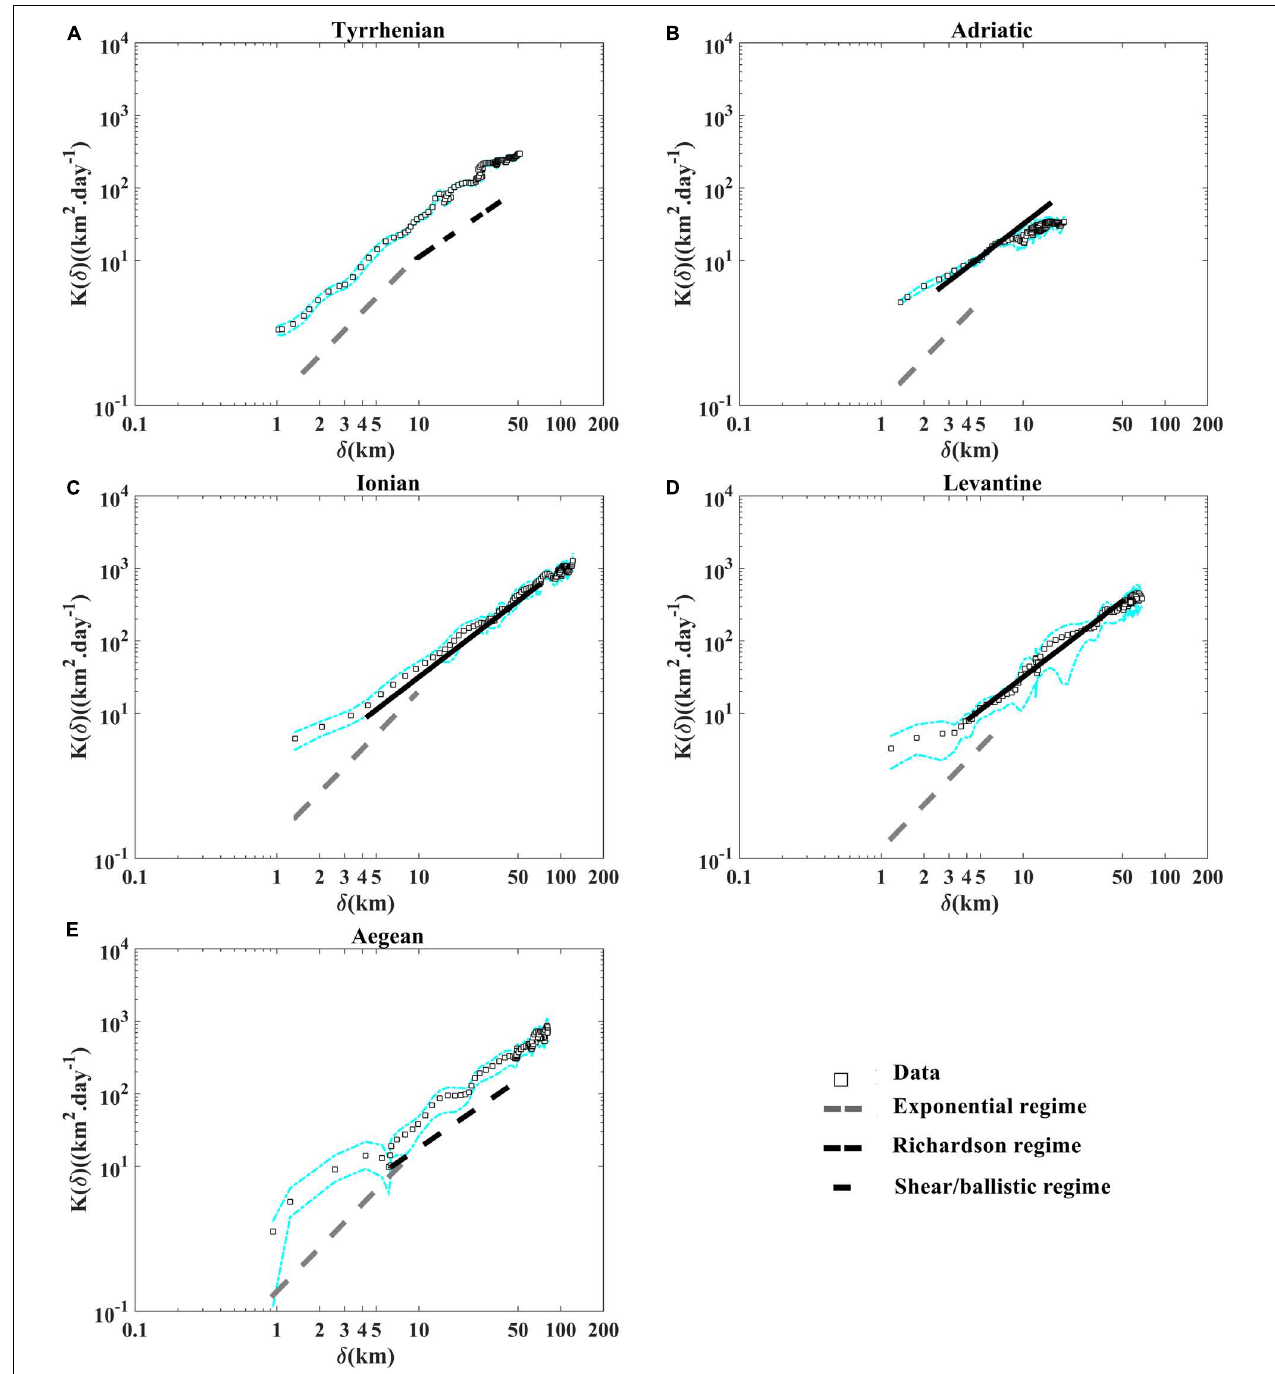
FIGURE 10 | Relative diffusivity as a function of separation distance derived from the second-order structure function in Eq. 6 (A) in the Tyrrhenian, (B) the Adriatic, (C) the Ionian, (D) the Levantine and (E) the Aegean sub-basins. The exponential, the Richardson and the shear/ballistic regimes are shown with the dashed gray, dashed black and black lines, respectively. The dashed cyan lines indicate the 90% confidence limits from bootstrap resampling, give a rough idea of the uncertainties for the statistics.